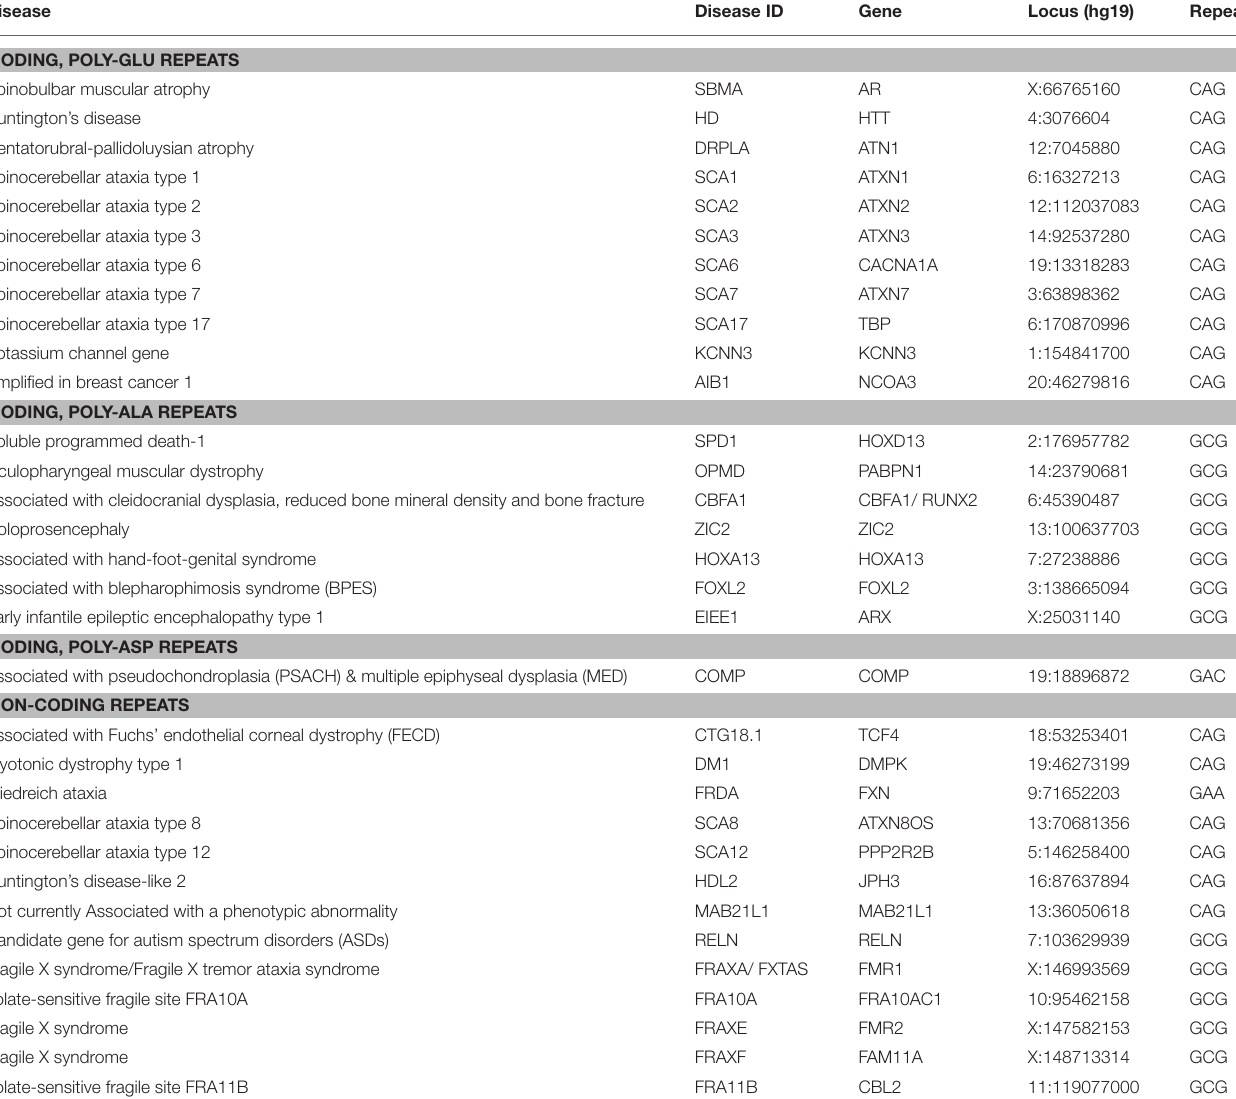
TABLE 1 | Disease-associated tri-nucleotide repeats examined in this study. Disease Disease ID Gene Locus (hg19) Repeat CODING, POLY-GLU